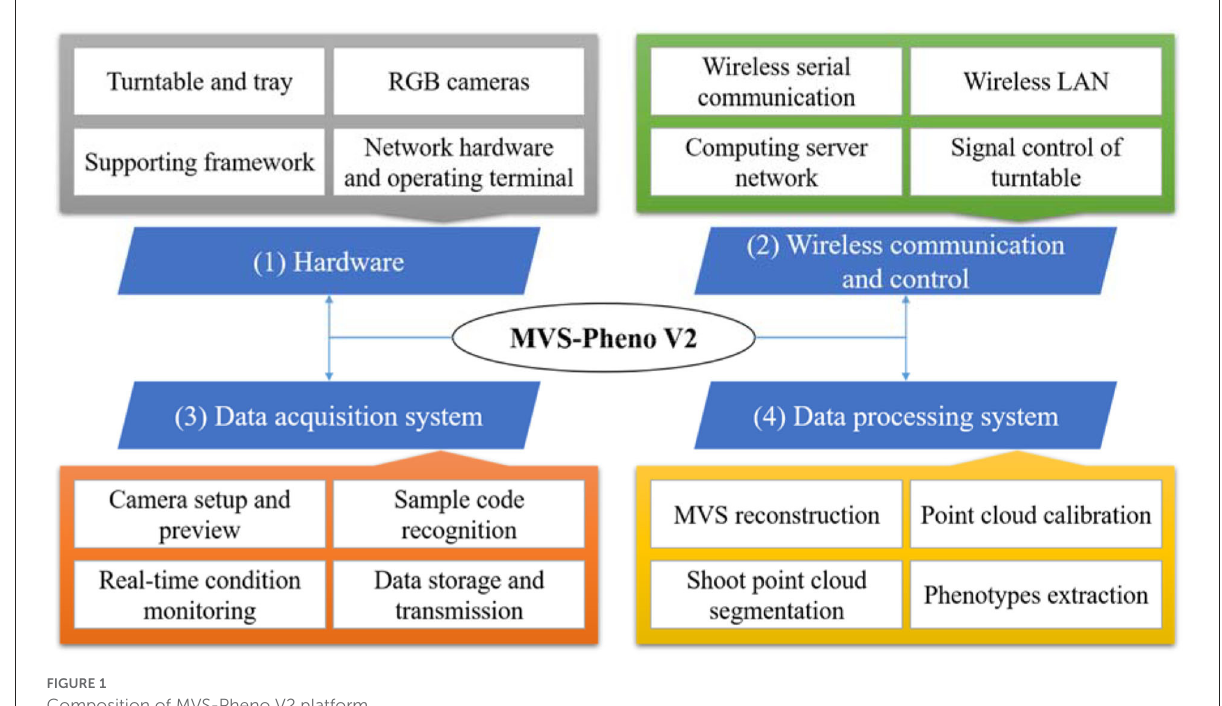
FIGURE1 Composition of MVS-Pheno V2